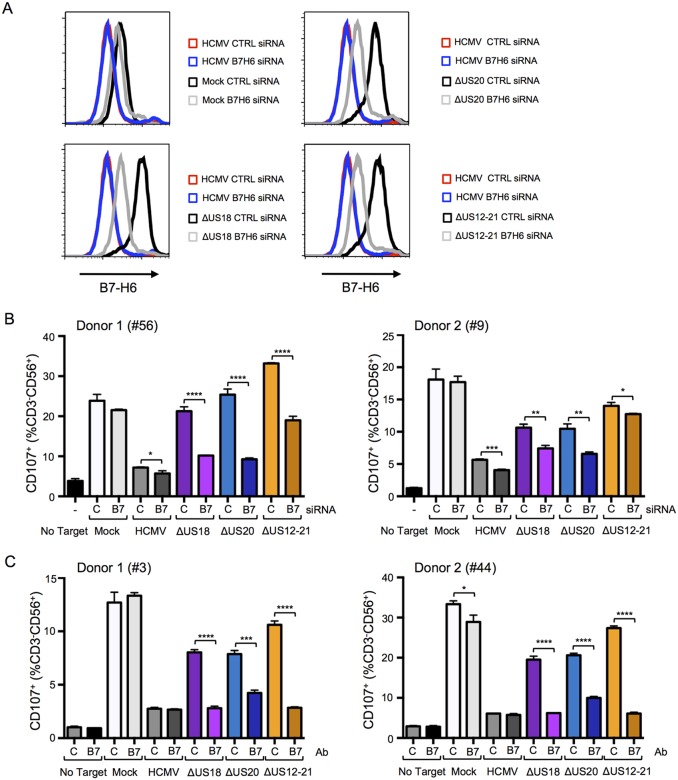
B7-H6 regulation has a major effect on NK activation in response to HCMV infection.(A and B) HF-TERTs were transfected with control (C) or B7-H6 (B7) siRNAs for 24 hr prior to infection with the parent HCMV, △US18, △US20 or △US12-21 mutants. Cells were harvested 72 h p.i. and B7-H6 cell surface expression analyzed by flow cytometry (E) or used as targets in a CD107 degranulation assay with donor-derived PBMC in triplicate (F). Results (mean and SD) were analyzed by unpaired two-tailed Student’s t-test and are representative of two independent experiments using 2 separate donors in each. Infected cells were assessed by the % cells with down-regulated MHC I compared to the mock-infected cells (HCMV CTRL siRNA 95%, ΔUS18 CTRL siRNA 91%, ΔUS20 CTRL siRNA 93%, ΔUS12-21 CTRL siRNA 86%, HCMV B7-H6 siRNA 96%, ΔUS18 B7-H6 siRNA 84%, ΔUS20 B7-H6 siRNA 96%, ΔUS12-21 B7-H6 siRNA 79%). (C) HF-TERTs infected with HCMV, △US18, △US20 or △US12-21 mutants were used as targets in a CD107 degranulation assay with donor-derived PBMC, in the presence isotype control (C) or B7-H6 (B7) blocking antibodies in triplicate. Results (mean and SD) were analyzed by unpaired two-tailed Student’s t-test and are shown for two separate donors. *p<0.05, **p<0.01, ***p<0.001, ****p<0.0001.